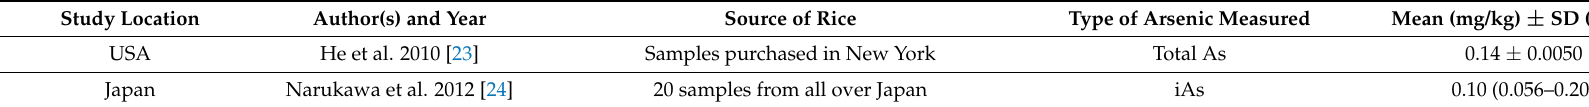
Table 1. Summary of studies assessing arsenic concentrations in